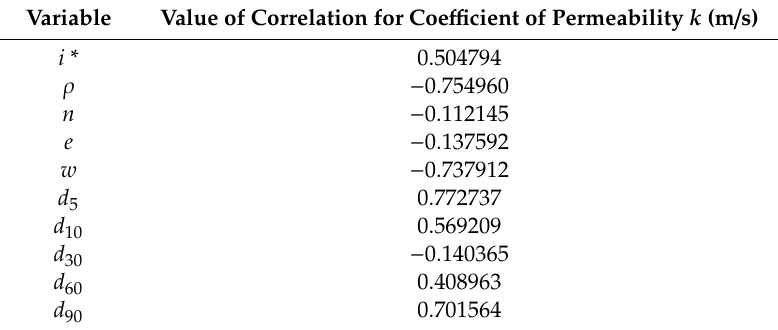
Table 2. Correlation table for coe ffi cient of permeability k (m /